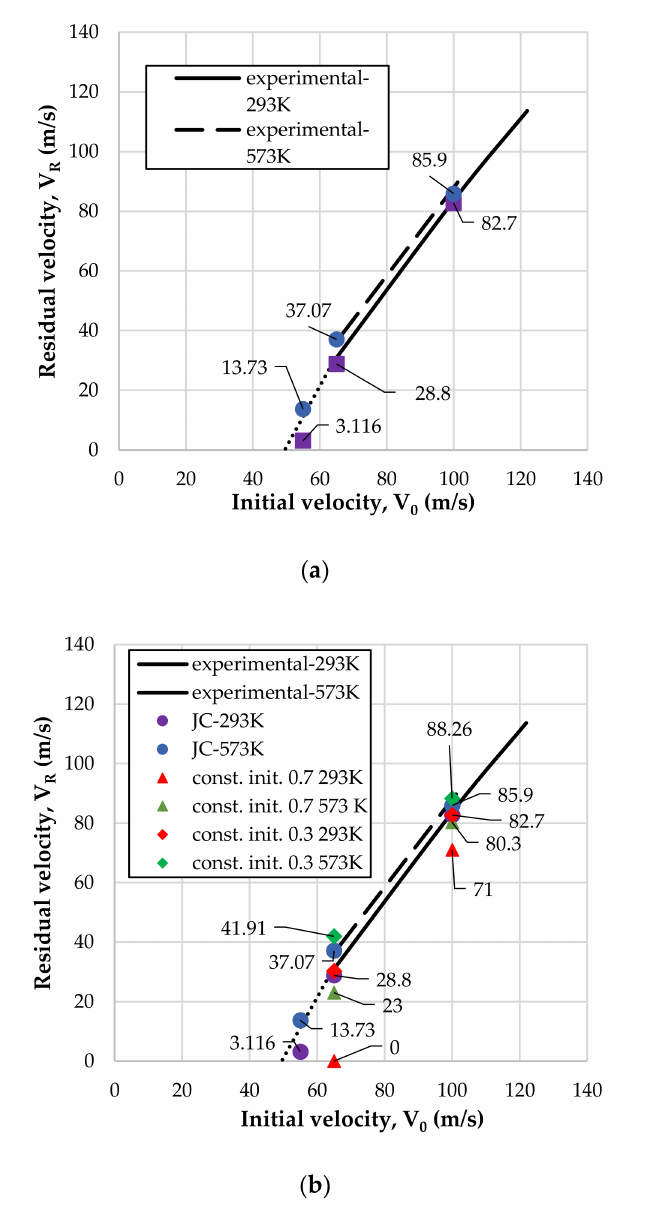
Figure 9. Ballistic curves V R vs V 0 : comparison of experimental and numerical results for T 0 = 293 K and T 0 = 573 K; ( a ) Johnson–Cook failure criterion (our work), ( b ) constant initiation damage